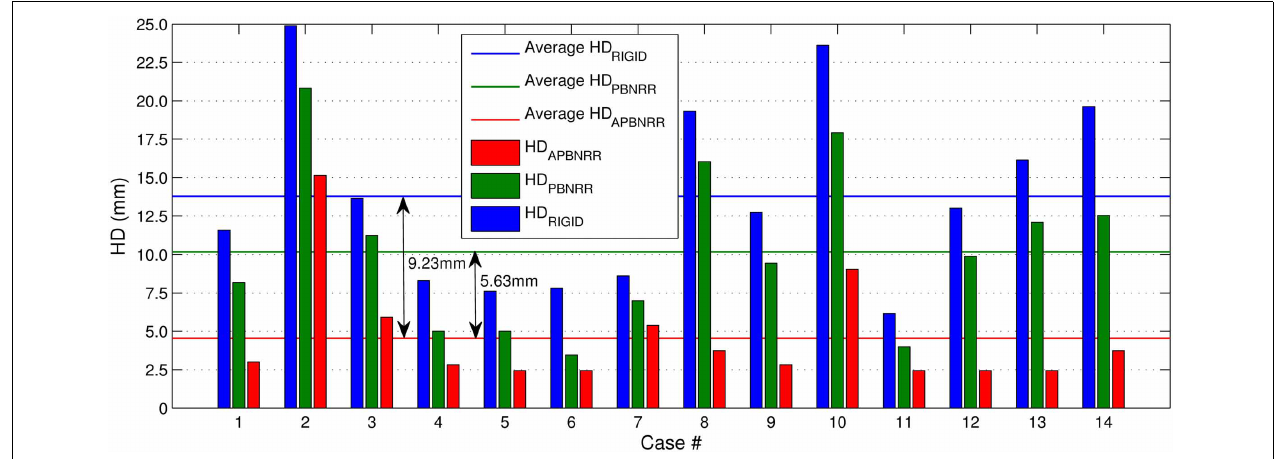
FIGURE 4 | The Hausdorff Distance (HD) alignment error for the 14 clinical cases. The horizontal lines illustrate the average HD error of each